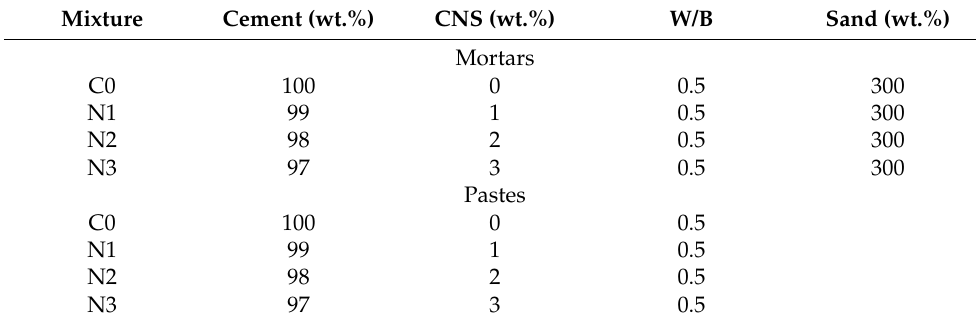
Table 3. Mix proportion of mortar and paste.